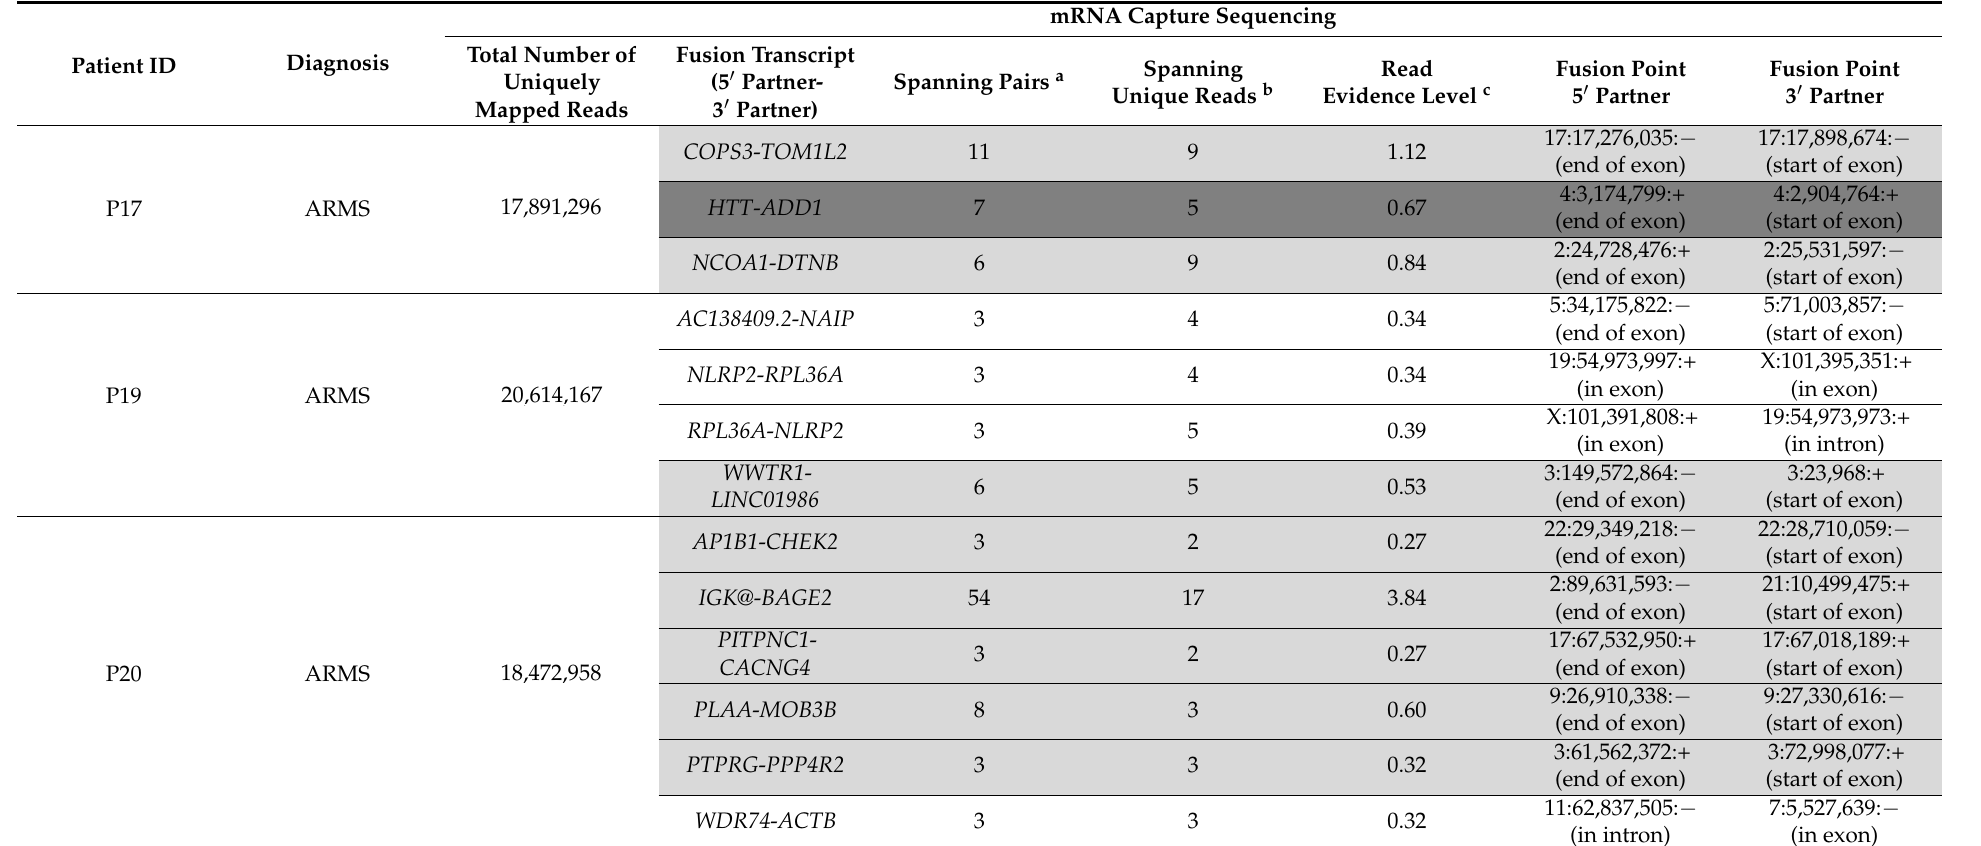
Table 2. mRNA capture sequencing identifies novel fusion transcripts in sarcoma. For patients in cohort II (unique patient ID), the TruSeq RNA Exome sequencing results of the prioritized novel fusion transcripts for RT-qPCR validation are listed. RT-qPCR confirmed transcripts are indicated in gray (light gray for assays designed using primerXL; dark gray for assays designed using the Shiny app DNA Melting Thermodynamic